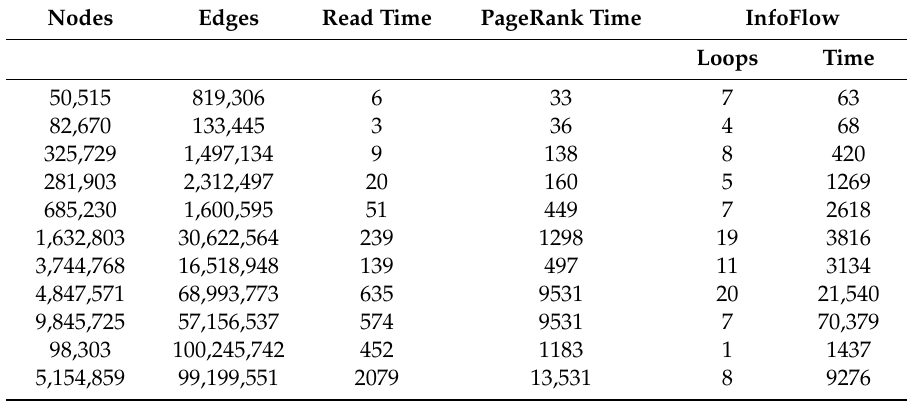
Table 2. Benchmarking results for InfoFlow, on the Dell Precision T3610, for datasets that challenge the limit the computer resource. The runtime for graph reading and PageRank calculations are listed to add perspective on community detection speed. Importantly, the number of loops are very small, indicating logarithmic complexity, and that the community detection runtime is on the same order of magnitude as PageRank. Since the latter is a prerequisite for the map equation approach to community detection, InfoFlow may have optimal runtime complexity for this class of algorithm. Runtime unit in seconds. The datasets are real world graphs taken from [26–28]. Nodes Edges Read Time PageRank Time